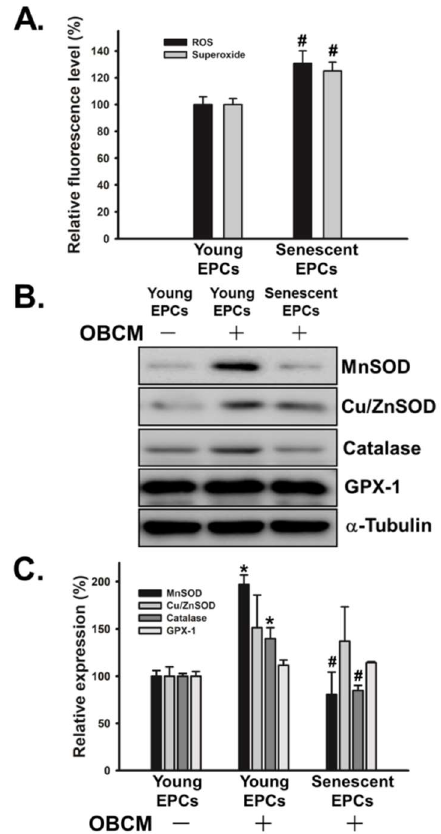
Figure 5. Effect of senescence on the content of ROS, superoxide, and antioxidant enzymes in OBCM-treated EPCs. ( A ) Young and senescent EPCs were incubated with OBCM of MC3T3-E1 cells for 24 h. Then, the production of ROS and superoxide was examined by ROS/superoxide detection kit ( N = 5); ( B , C ) Young and senescent EPCs were treated with or without OBCM of MC3T3-E1 cells for 24 h. After treatment, cells were harvested and lysed for the detection of antioxidant enzymes by Western blot analysis ( N = 5). The quantitative densitometry of the relative level of signals was performed with Image-Pro Plus. Data are expressed as mean ± S.E.M. of five independent experiments. * p < 0.05 compared with the basal group (without OBCM). # p < 0.05 compared with the group of young EPCs.